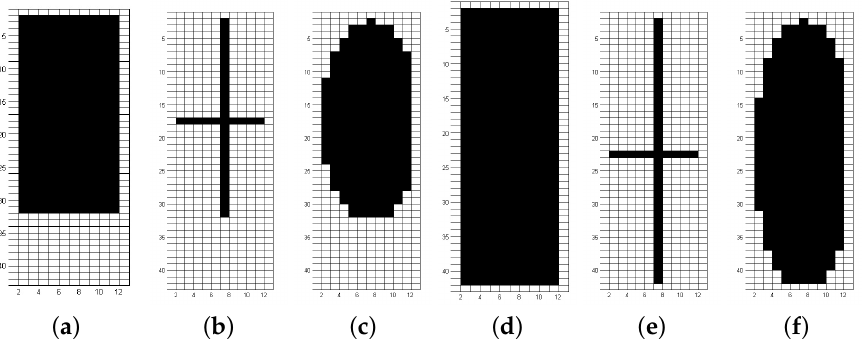
Figure 20. The structuring elements used um Opening operation. ( a ) rectangular, size 30 × 10; ( b ) cross-shaped, size 30 × 10; ( c ) elliptical, size 30 × 10; ( d ) rectangular, size 40 × 10; ( e ) cross-shaped, size 40 × 10; ( f ) elliptical, size 40 ×